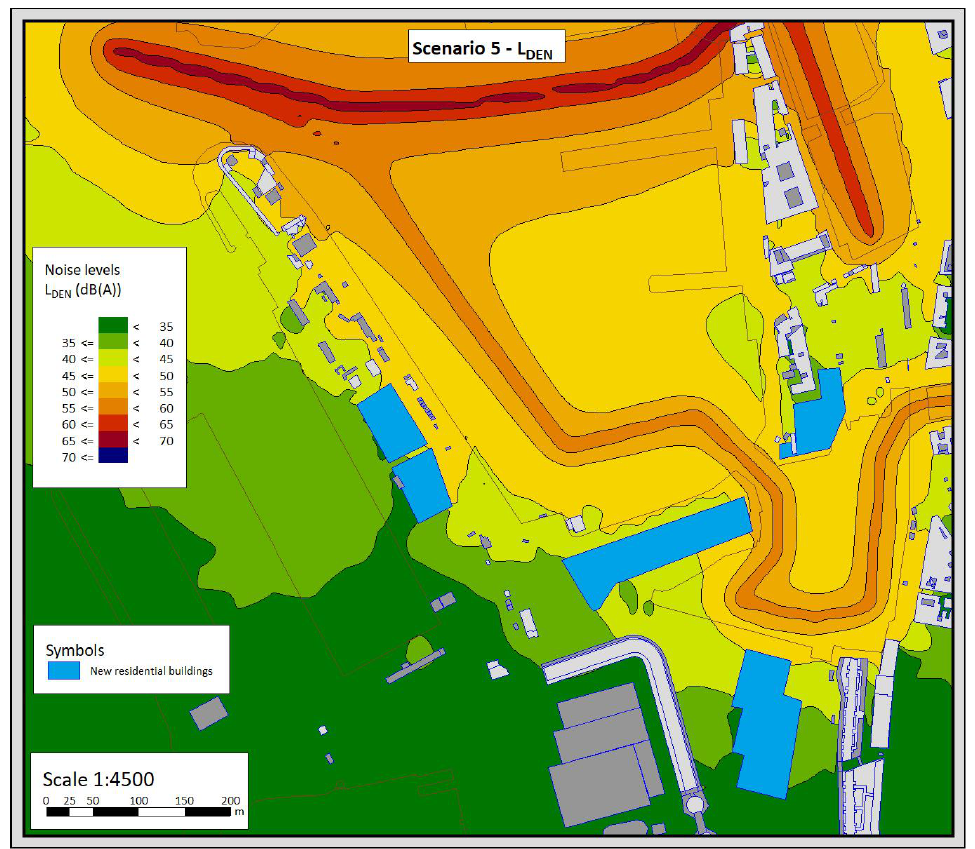
Figure 11. L DEN noise contour map for the southern area of the port in Scenario 5.